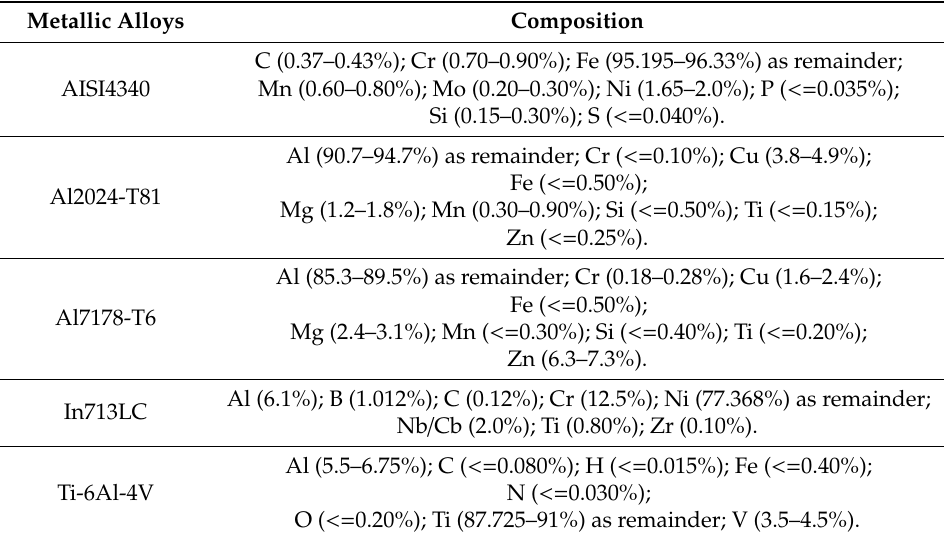
Table 1. Compositions of the metallic alloys in terms of elements percentage.